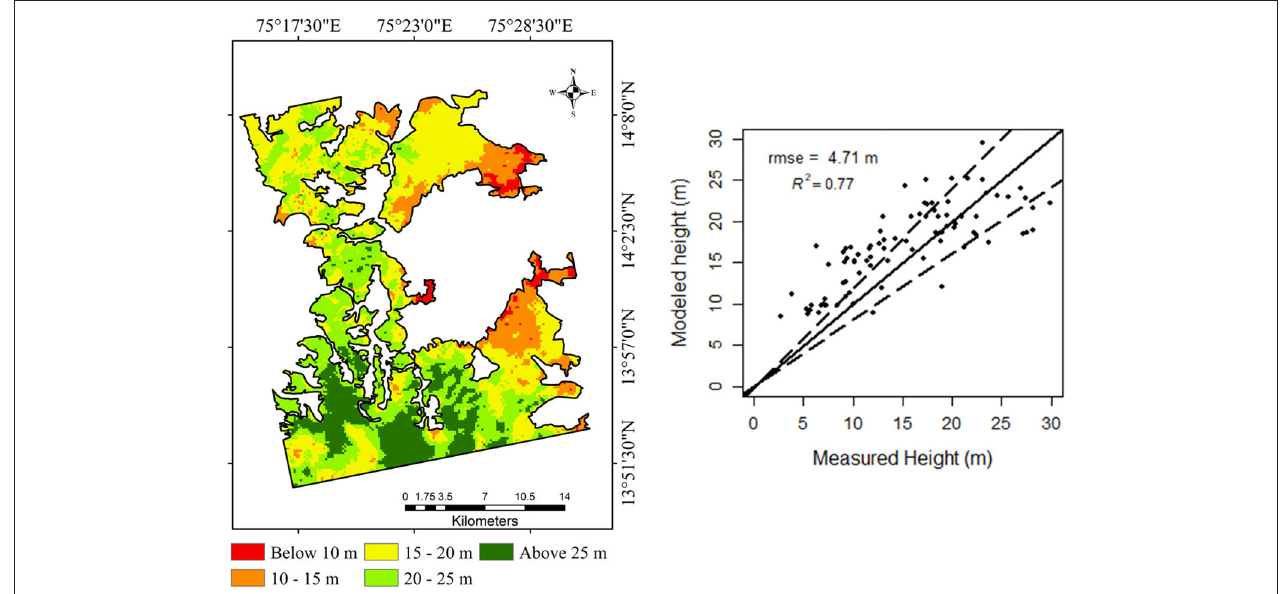
FIGURE 5 | Validation of simple kriging interpolated GEDI forest stand height. The solid black line shows a 1:1 line and the dotted lines indicate a 20% error limit.